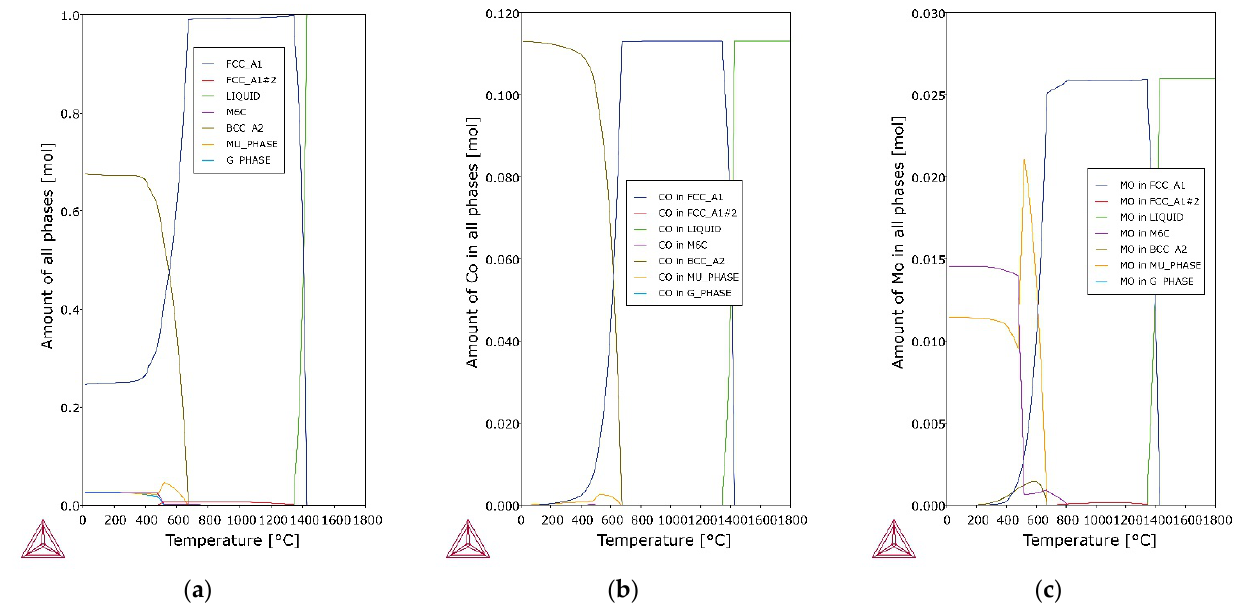
Figure 5. Thermodynamic diagrams of Fe-0.0768C-0.921Si-0.168Mn-4.38Mo-16.9Ni-11.7Co-0.332Ti model alloy: ( a ) amount of all phases, ( b ) amount of Co in all phases, ( c ) amount of Mo in all phases.